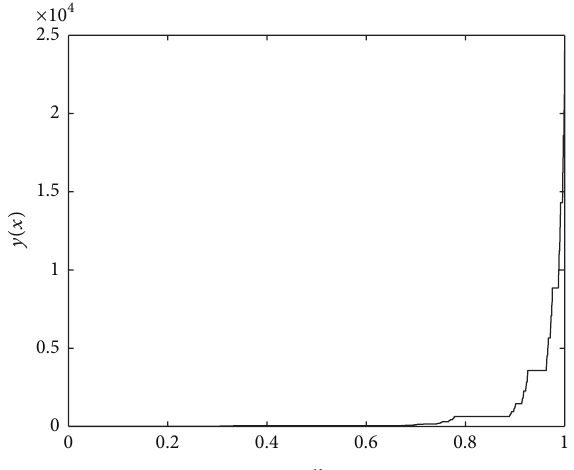
Figure 4: The graph of (22) with parameters 𝛽 = 1 , 𝜆 0 = 3 , and = 0 . Figure 5: The graph of (22) with parameters 𝛽 = 1 , 𝜆 𝑡 0